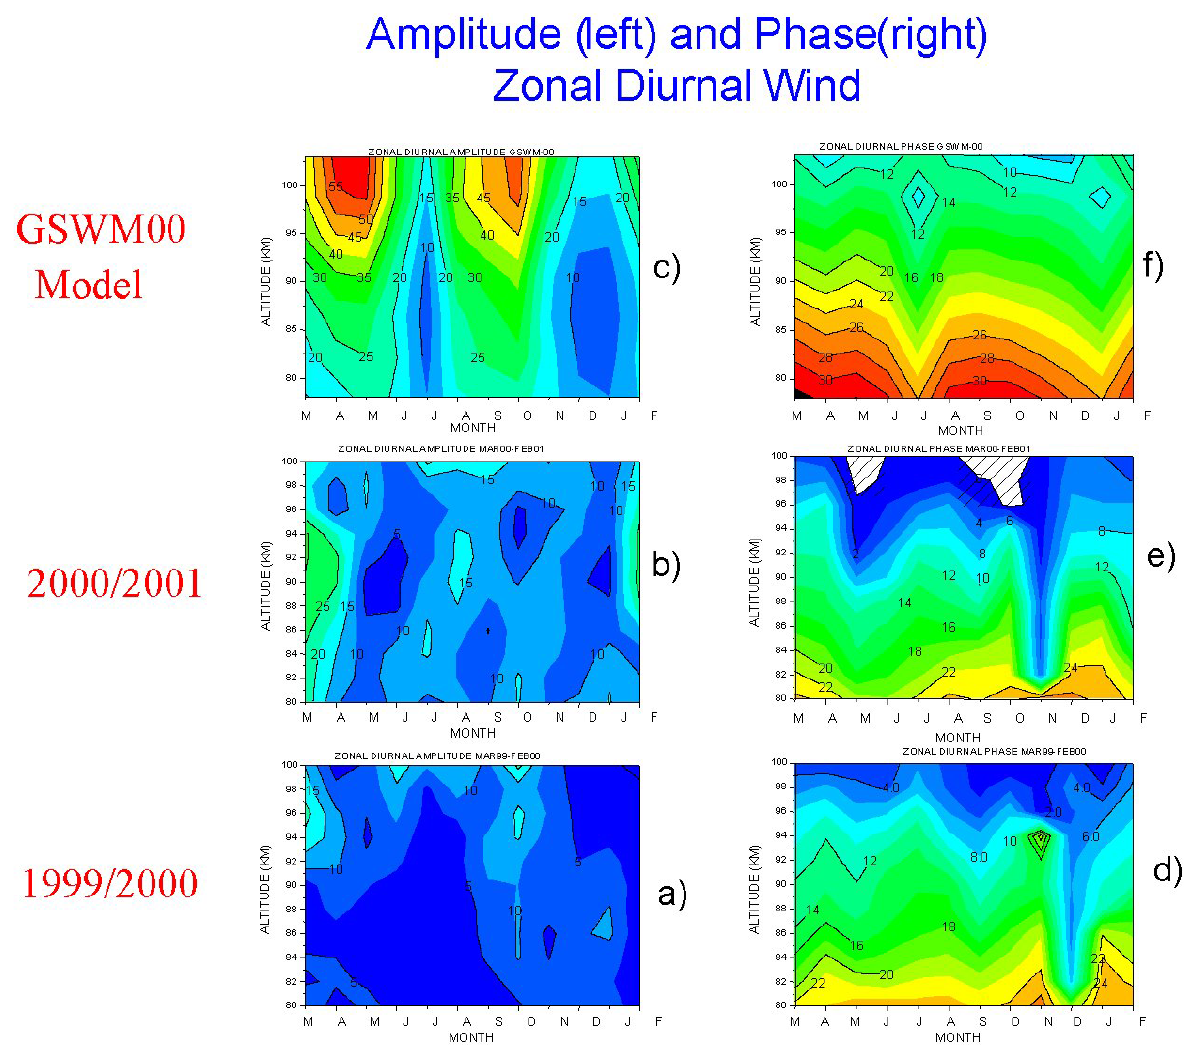
Fig. 9. Amplitude and phase of the diurnal zonal wind measured at Cachoeira Paulista (23 ◦ S), compared with GSWM00 (after Batista et al.,